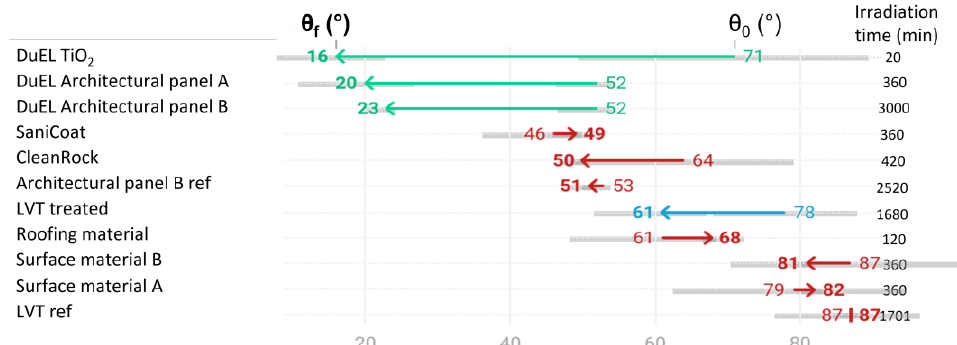
Figure 4. Overview of the evolution the water contact angle from the oleic-acid-fouled surface before UV irradiation ( θ 0 ) to the final contact angle after UV irradiation ( θ f ) and the corresponding required irradiation time (t f ) in minutes. The samples can be divided into three groups: the photocatalytically active samples (green arrows), the semi-active samples (blue arrows) and the inactive samples (red arrows). The grey bars represent the experimental error.